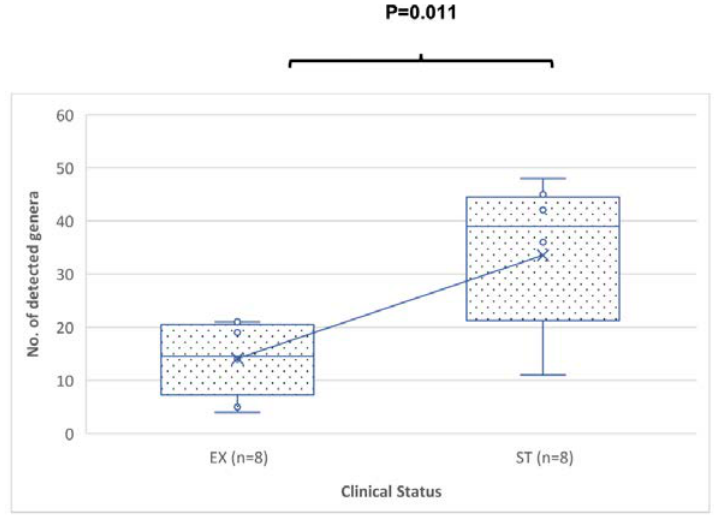
Figure 2. Comparison of the number of genera from sputum specimens from patients in the EX versus ST states. The p -value was =0.011 using the Mann–Whitney U test. The median is represented by a horizontal line inside each box, (x) represents the mean, the interquartile range is indicated by the boxes, and the whiskers denote the range. The numbers of detected genera represent the numbers of any genera with a relative percentage abundance of greater than 0%. Table 2. The relative percentage of genera detected in the study samples.